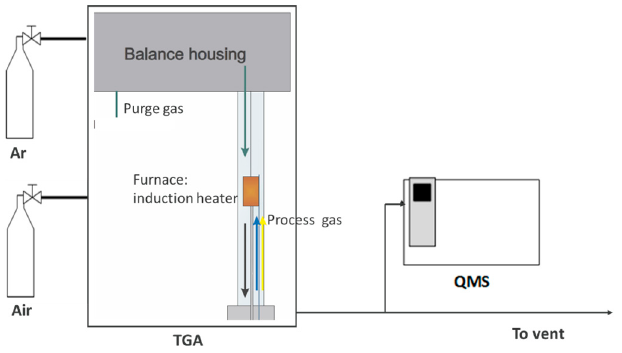
Figure 1. Schematic diagram of a thermogravimetric analyzer-quadrupole mass spectrometer (TGA-QMS) system used in this study.